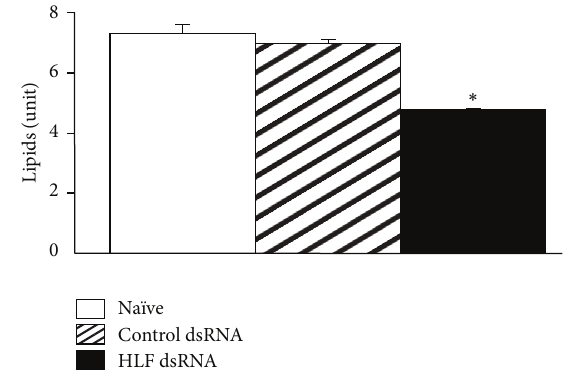
Figure6:EffectofmammalianHLFRNAionlipidcontentinmouse 3T3-L1 cells. Cells in culture were transfected with control and HLF dsRNA and processed for lipid assay 48 h later (see text for details). Lipid content in 3T3-L1 cells was reduced by HLF dsRNA treatment ( ∗ 𝑃 < 0.001 versus na¨ıve; 𝑛 = 6 ; mean ± standard error mean), which also reduced HLF mRNA content (not shown).